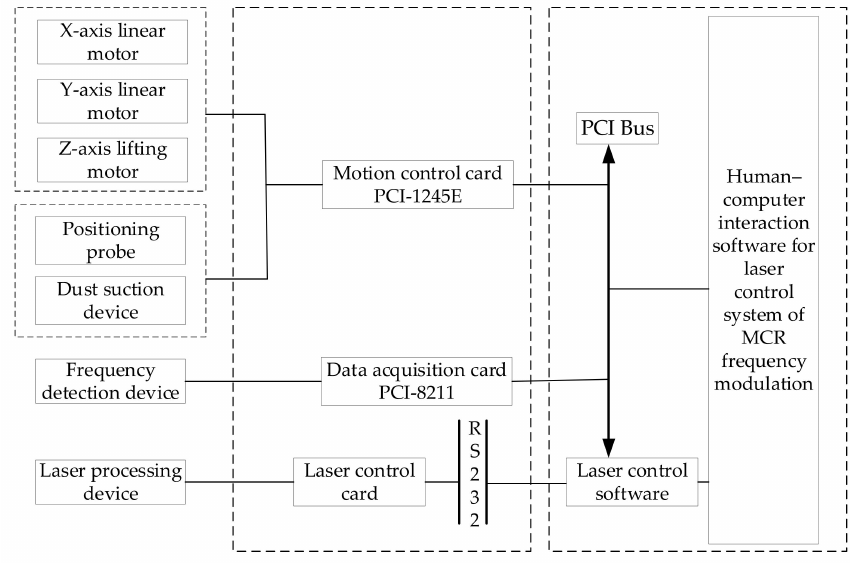
Figure 10. Data transmission link diagram.